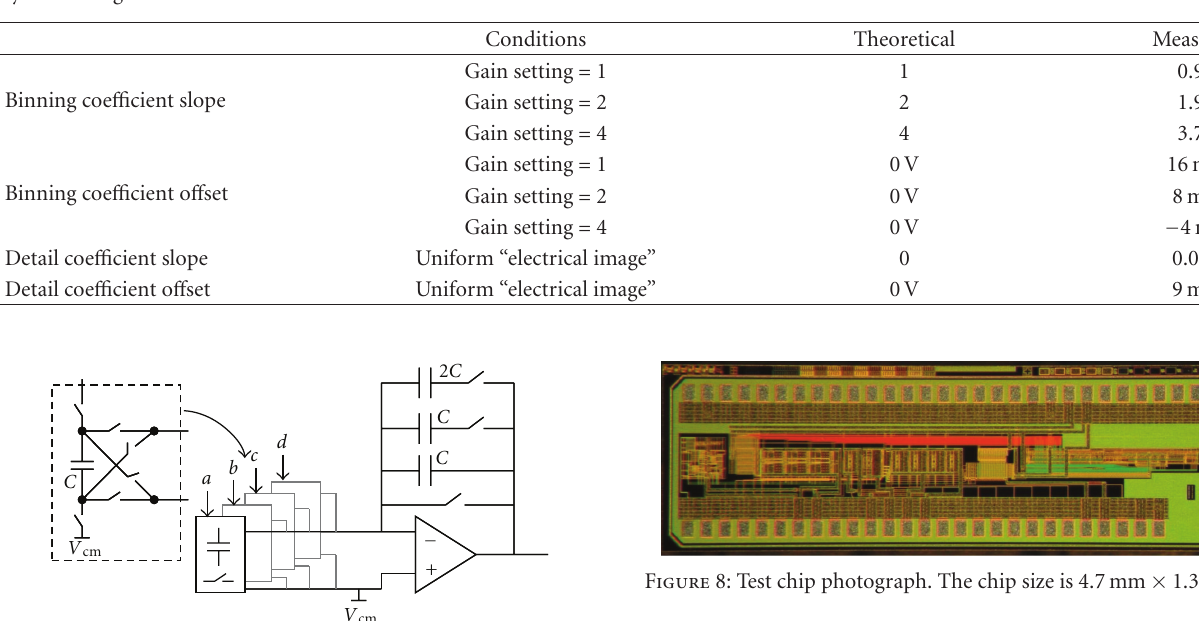
Table 1: Theoretical and measured characteristics of binning and detail coe ffi cients. Conditions: input a = b = c = d swept along full dynamic range.